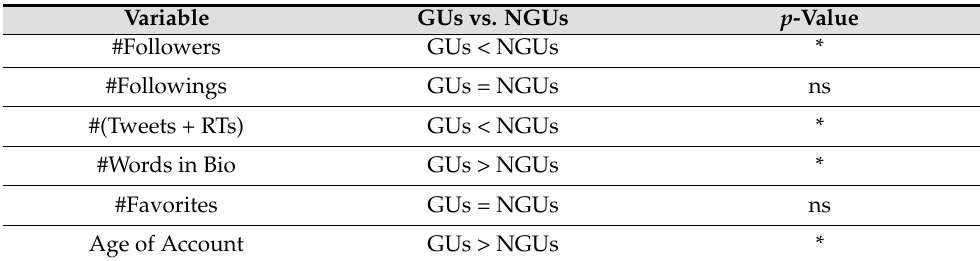
Table 3. GUs vs. NGUs based on profile information.